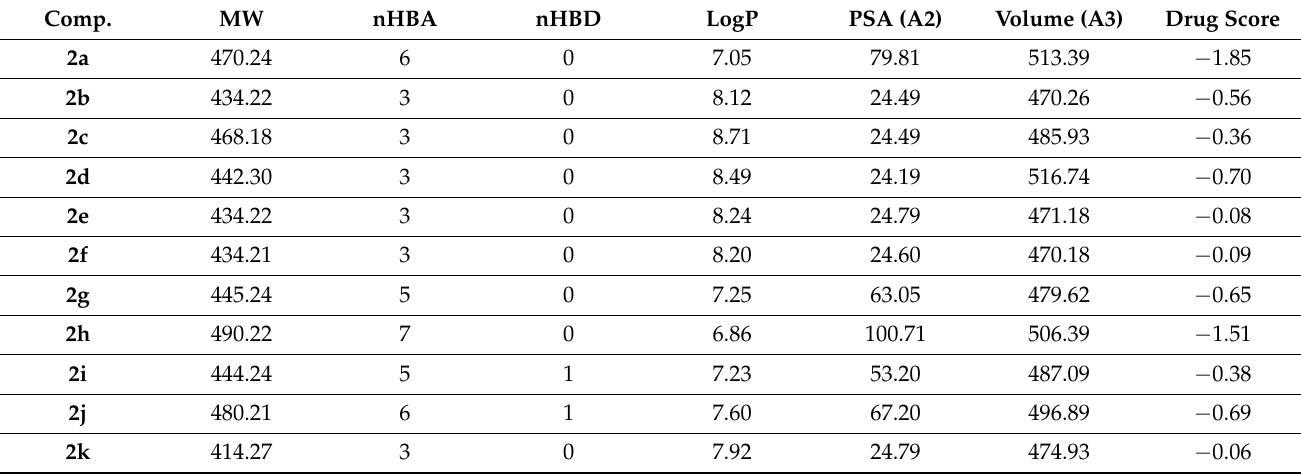
Table 5. Cheminformatics properties ( 2a – 2k